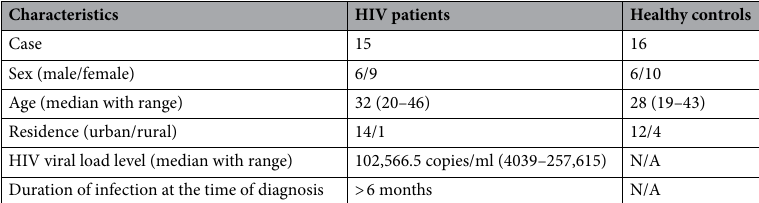
Table 1. Characteristics of HAART naïve HIV patients and healthy controls.